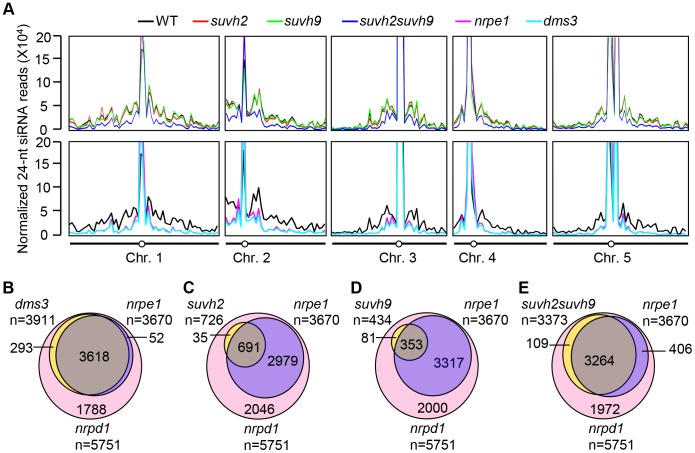
Small RNA analyses by small RNA Northern blotting and small RNA deep sequencing.(A) Diagrams show the distribution of Pol IV-dependent 24-nt siRNAs across all five Arabidopsis chromosomes in the wild type, suvh2, suvh9, suvh2suvh9, nrpe1, and dms3. Normalized 24-nt siRNA reads per ten million in consecutive 500-Kb genomic regions of each chromosome are indicated by the Y coordinate, whereas all five Arabidopsis chromosomes are shown along the X coordinate. (B–D) Venn diagrams indicate the numbers and overlaps of siRNA regions that show decreased siRNAs in dms3 (B), suvh2 (C), suvh9 (D), and suvh2suvh9. (E) compared to nrpd1 and nrpe1. The results are from the small RNA deep sequencing data for the wild type, nrpd1, nrpe1, dms3, suvh2, suvh9, and suvh2suvh9.